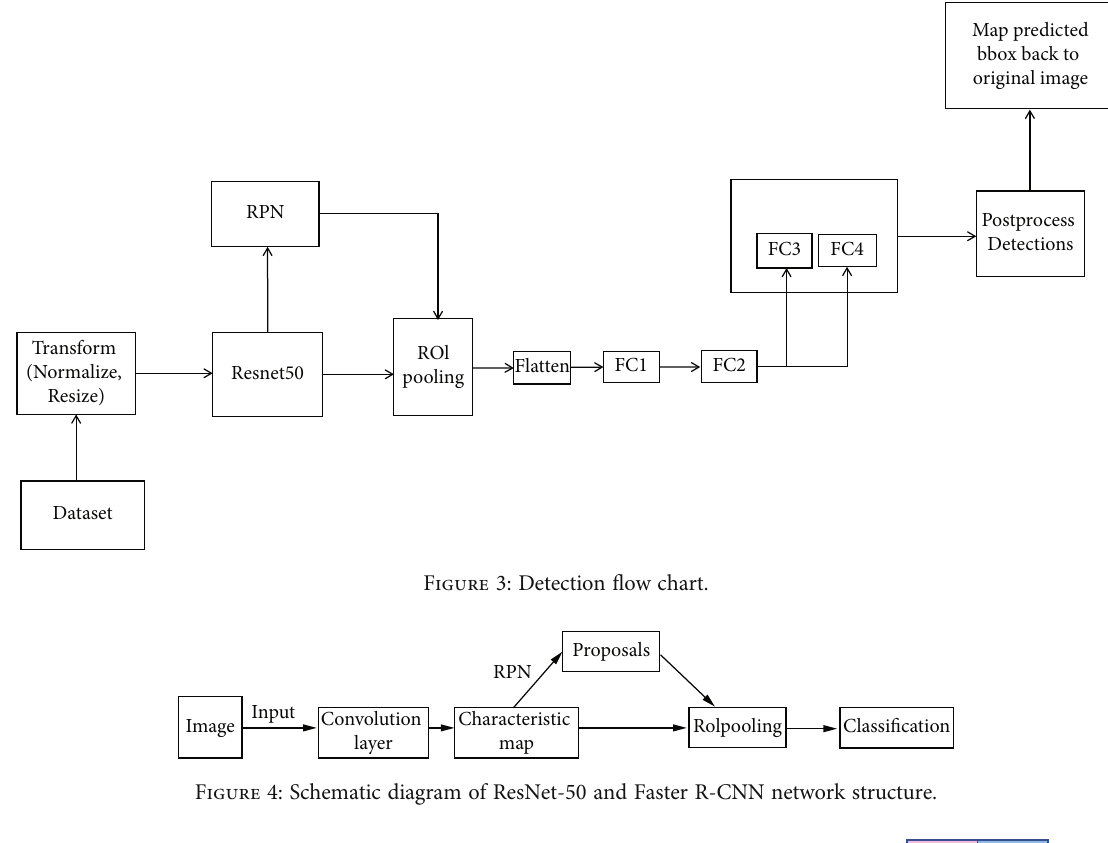
Figure 4: Schematic diagram of ResNet-50 and Faster R-CNN network structure.